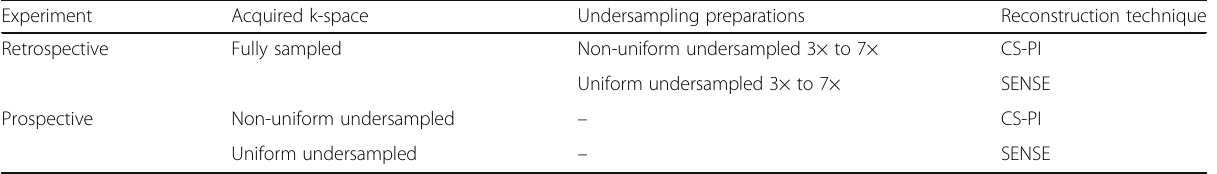
Table 3 Schematic overview of undersampling and reconstruction pipeline of retrospective undersampled and prospective undersampled